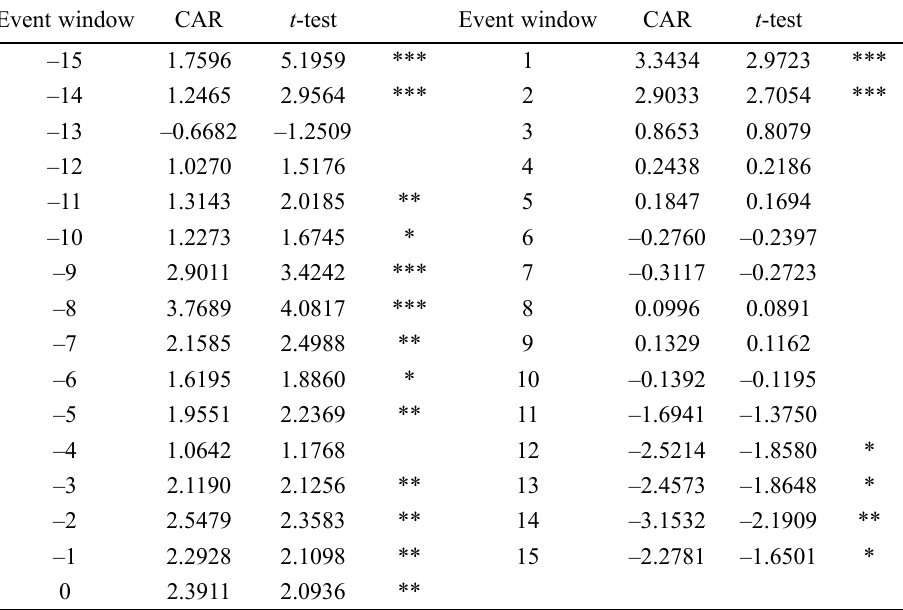
Table 2. CAR of biotechnology industry during the period of infectious diseases Event window